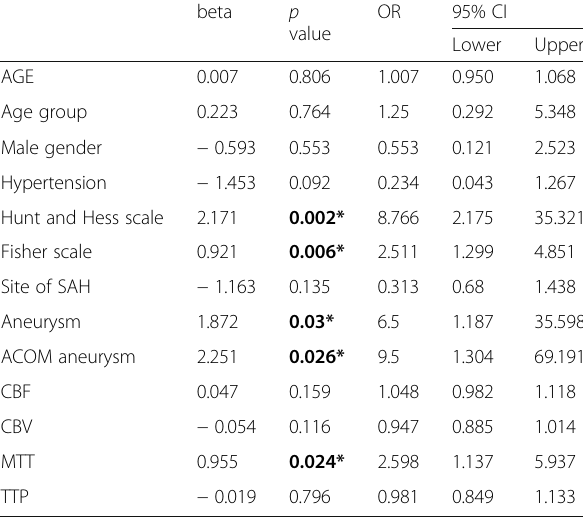
Table 3 Logistic regression of predictors of